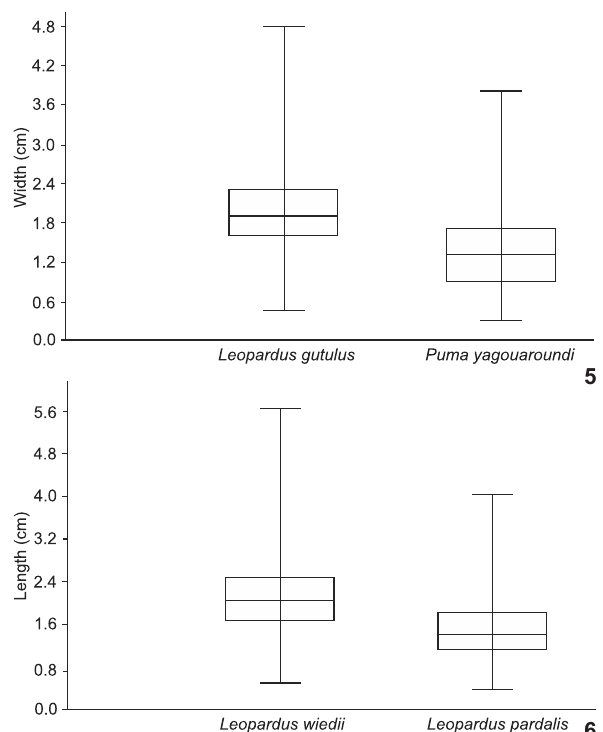
Figures 5-6. Quotient of width and length (cm) of guard hairs scales for each pair of small Neotropical felids: (5) Leopardus guttulus and Puma yagouaroundi ; (6) L. wiedii and L. pardalis .